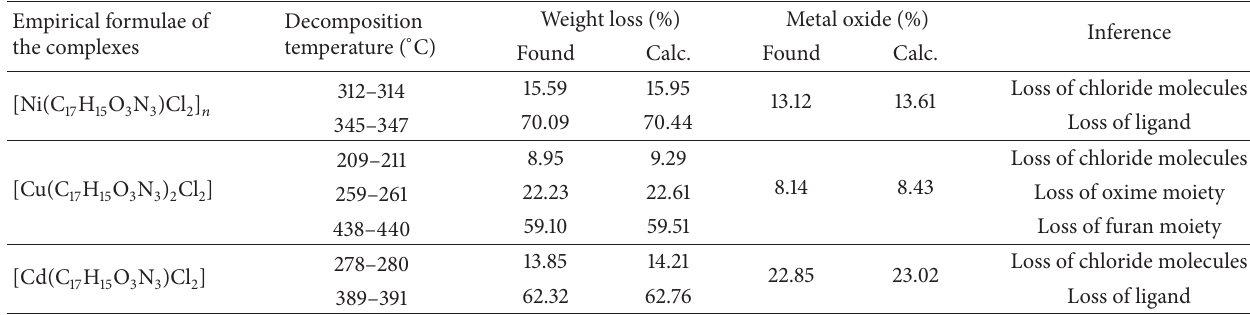
23.64 Inference